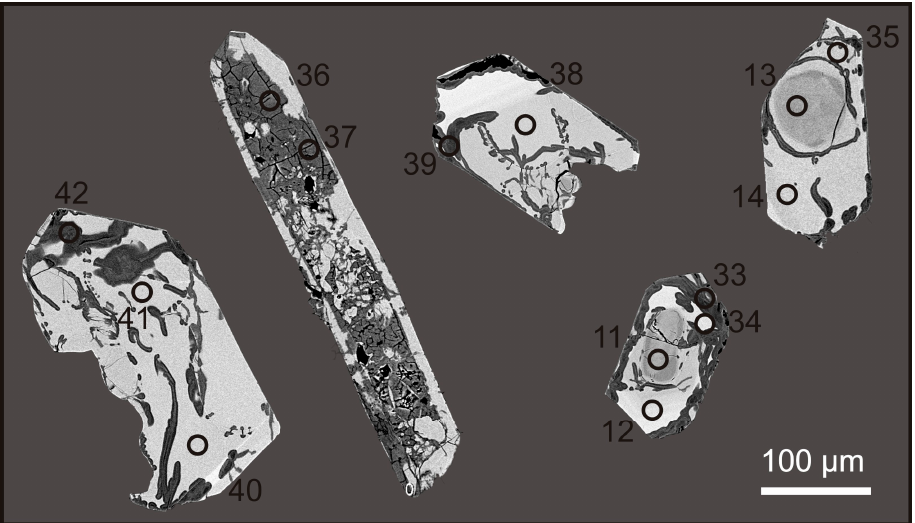
Figure 4. BSE images of zircons from the pegmatite vein (sample 101d). Circles indicate the SIMS analytical spots with their numbers corresponding to those in Tables S1 and S2.